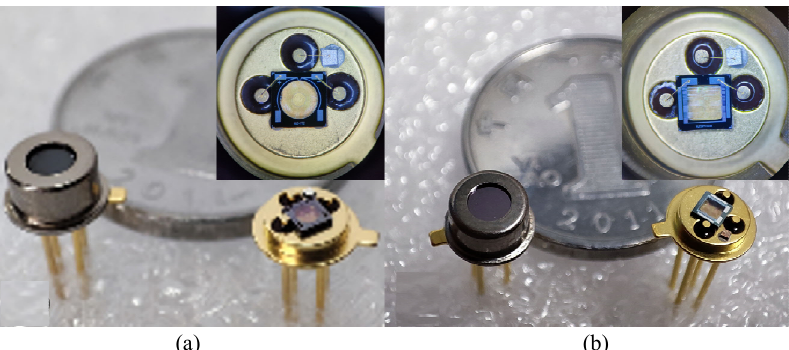
Fig. 6 Thermopile infrared detector with TO package: (a) circular thermopile and (b) double-ended symmetrical rectangular thermopile.